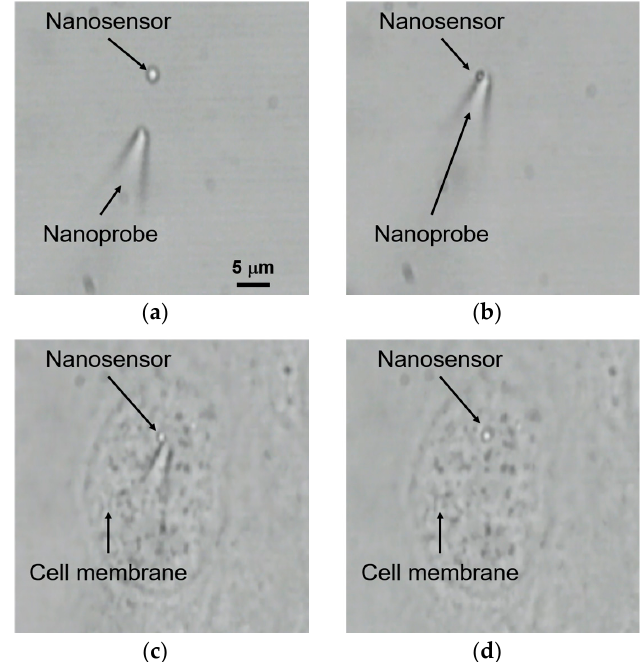
Figure 7. Pick-up and immobilization of the nanosensor using a micromanipulator and optical control of the zeta potential. ( a ) Approach of the glass nanoprobe under UV irradiation; ( b ) Pick-up of the nanosensor; ( c ) Contact of the nanosensor to the membrane of an Madin–Darby Canine Kidney (MDCK) cell; ( d ) After immobilization of the nanosensor. Table 1. Success rate of pick-up of the nanosensor by the glass nanoprobe without/with UV irradiation. DMEM: Dulbecco’s Modified Eagle Medium; FBS: Fetal bovine serum; PBS: Phosphate-buffered saline.